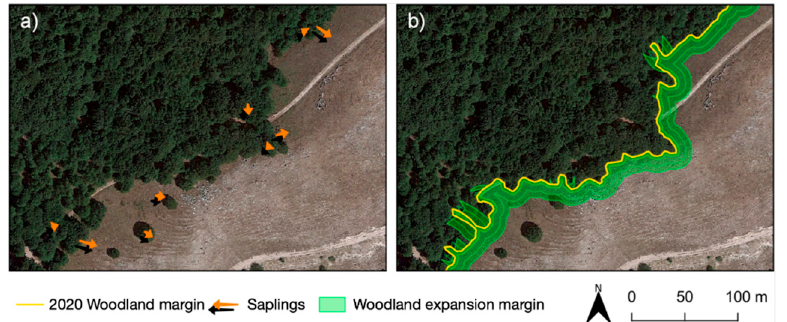
Figure 5. ( a ) Position of propagules and distance from mature trees of the same species; ( b ) woodland edge expansion, calculated as a buffer the size of the mean distance (MD = 7.42 m), MD − SD (2.37 m), MD + SD (12.49 m). Satellite image attributed to Image ©2019 Google.